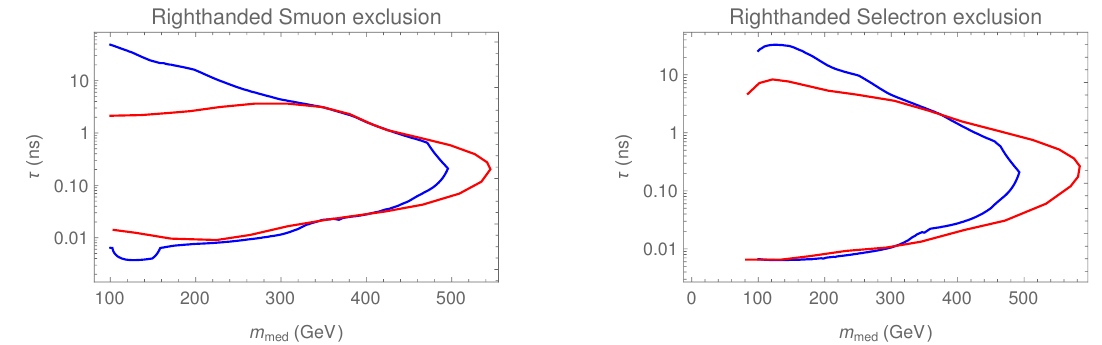
Figure 16. Validation of the DL performed by ATLAS [70]. Left: right-handed smuon production. Right: right-handed selectron